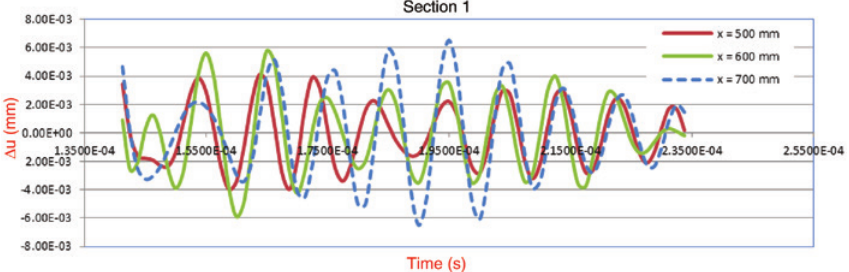
Figure 21: Time domain response at Section 1 with varying damage locations.